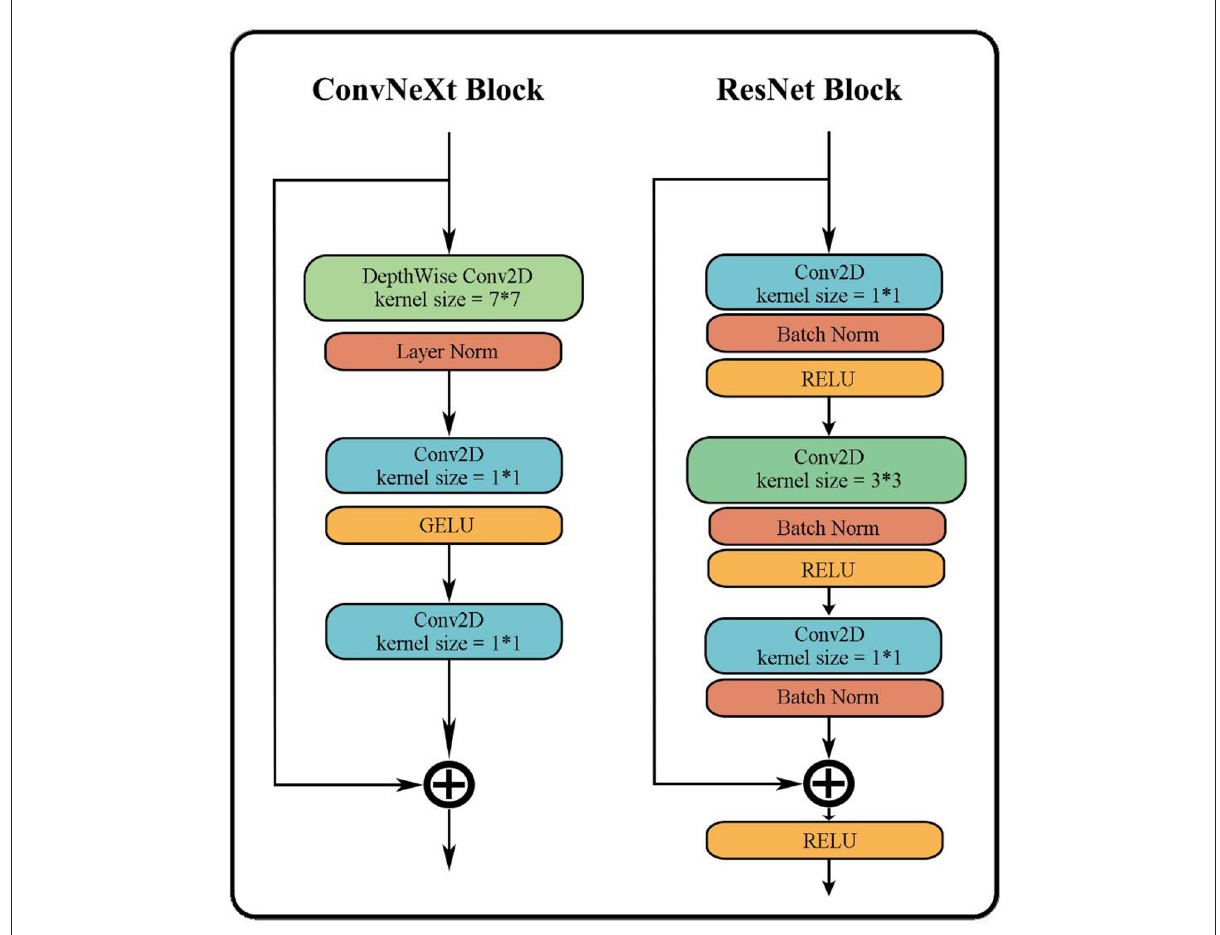
FIGURE5 Differences between ConvNeXt and ResNet in